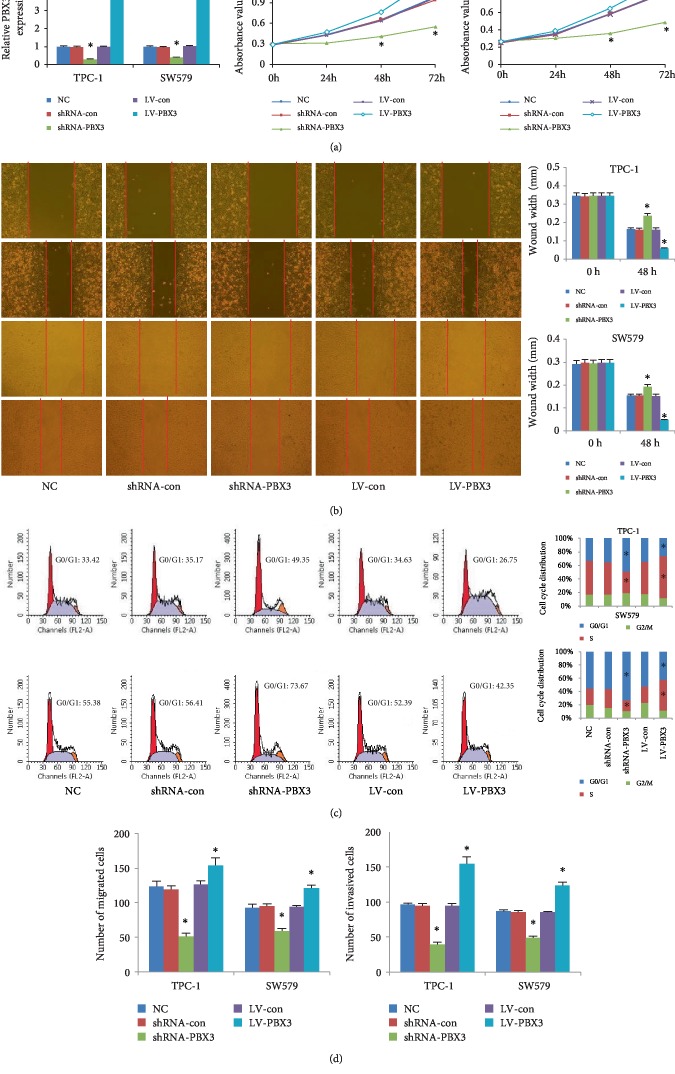
Effects of PBX3 on PTC cell proliferation, migration, and invasion. (a) The growth rates of PBX3-overexpressing or HPIP-knockdown PTC cells (TPC-1 and SW579). (b) Cell migration was determined over 48 h by wound healing assay. (c) The cell cycle was assessed by flow cytometry analysis. (d) Cell migration was assessed by transwell assays and cell invasion by the matrigel invasion chamber. All values are shown as mean ± SD (n = 3). ∗P0.05 versus control group.